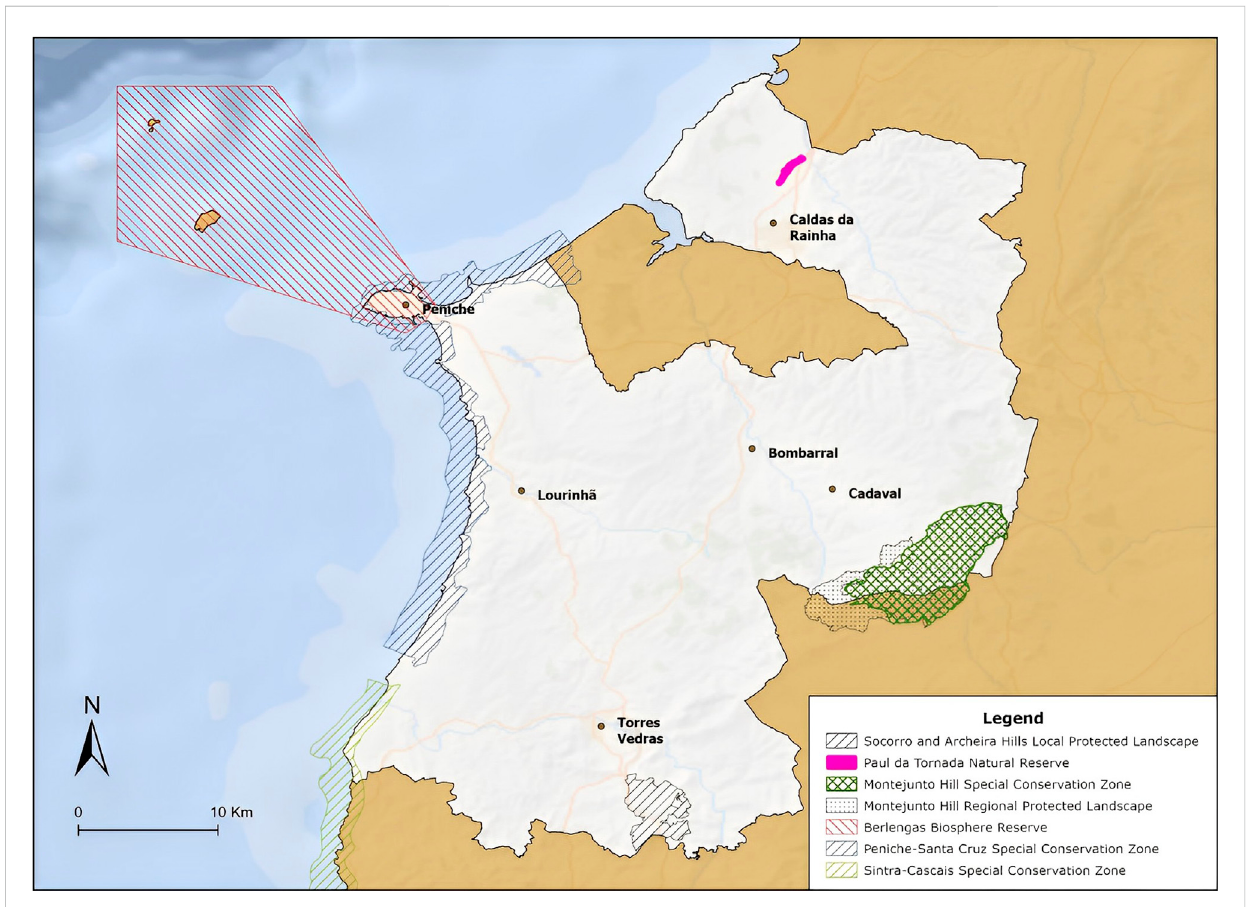
FIGURE 2 Protected natural spaces in the territory of the aspiring Oeste Geopark. Source: fi le made available by the aspiring Oeste Geopark team (2021).